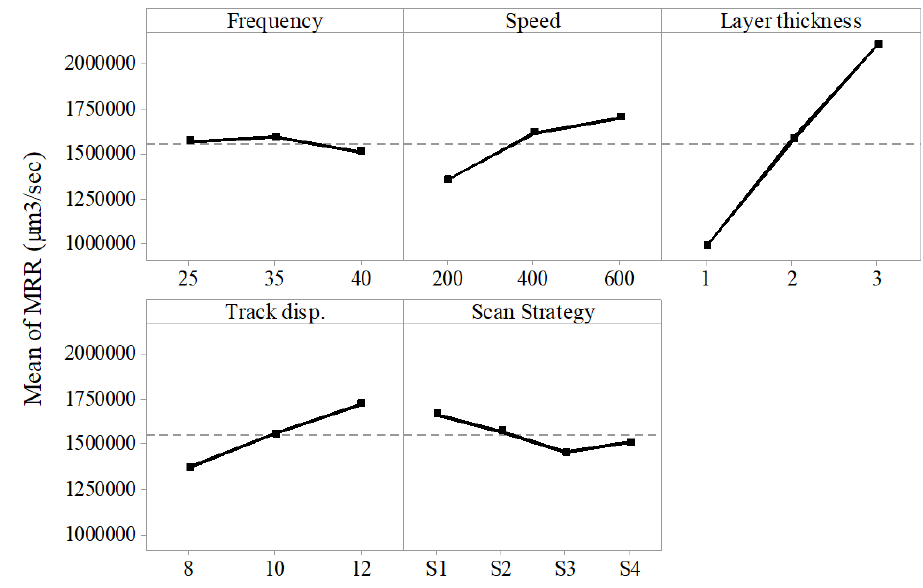
ff ect of process parameters on MRR. Figure 10. Effect of process parameters on MRR . Figure 10. E